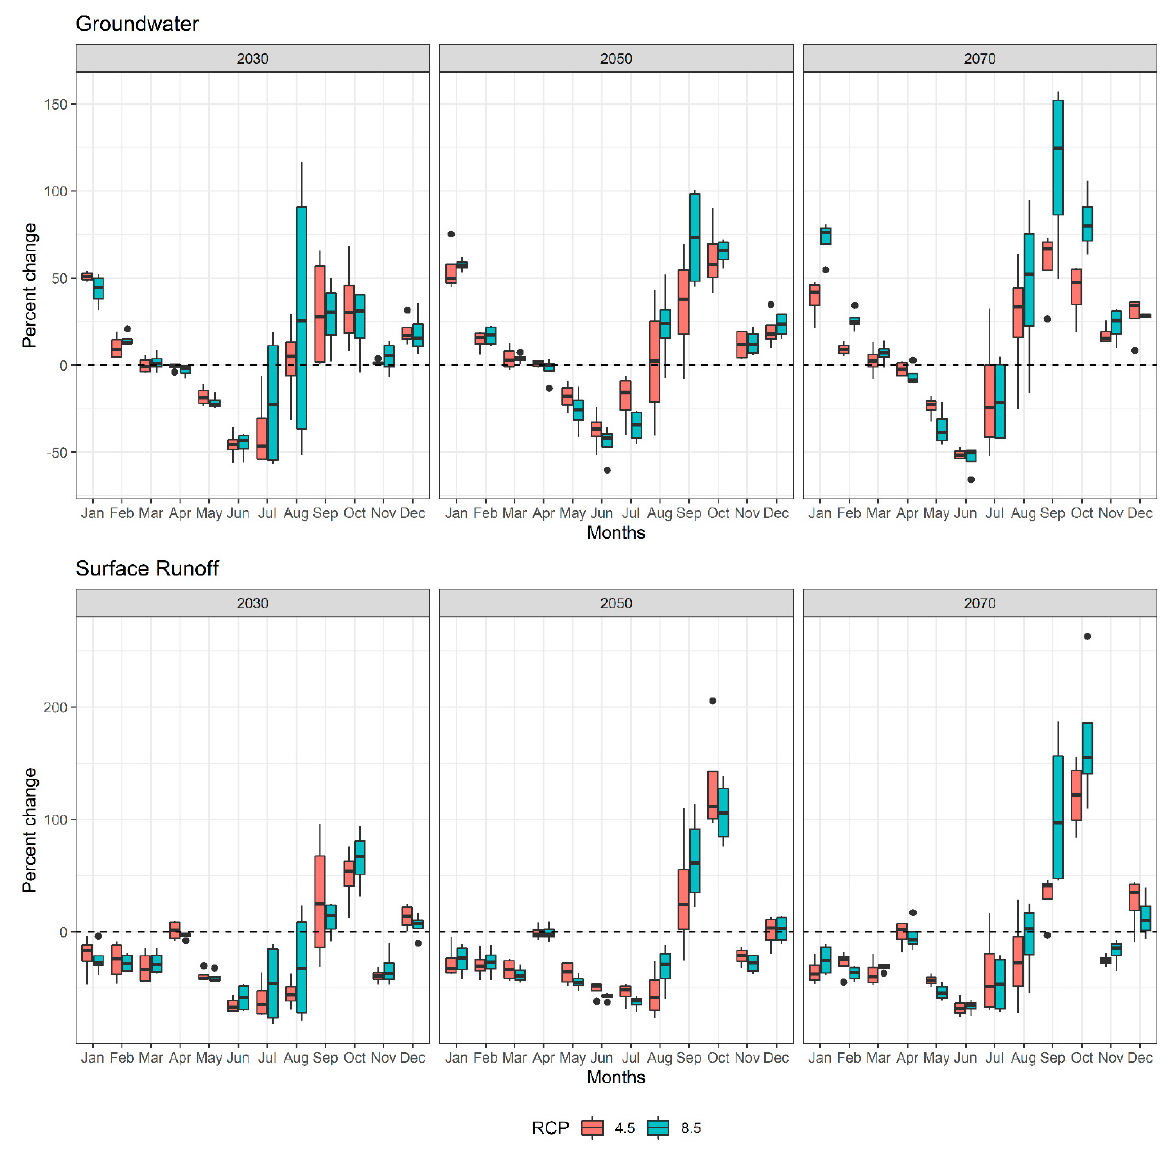
Figure 7. Projected monthly changes in groundwater and surface runoff in Deckers Creek Watershed, Morgantown, West Virginia, USA. Box and whisker plot represent ensemble percentage change for four GCMs under two RCPs (RCP 4.5 and RCP 8.5). Projections are for 3 future periods of 20-year interval (2030s = 2031 − 2050, 2050s = 2051 − 2070, 2070s = 2071 − 2090). The dotted line represents the historical baseline of 1980 − 1999.